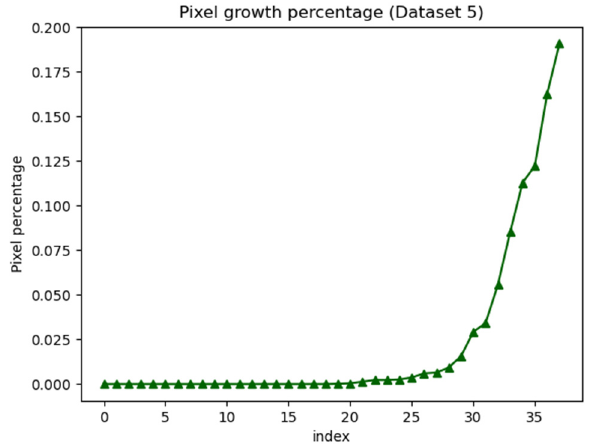
Figure 36. Graph of pixel growth ratio.